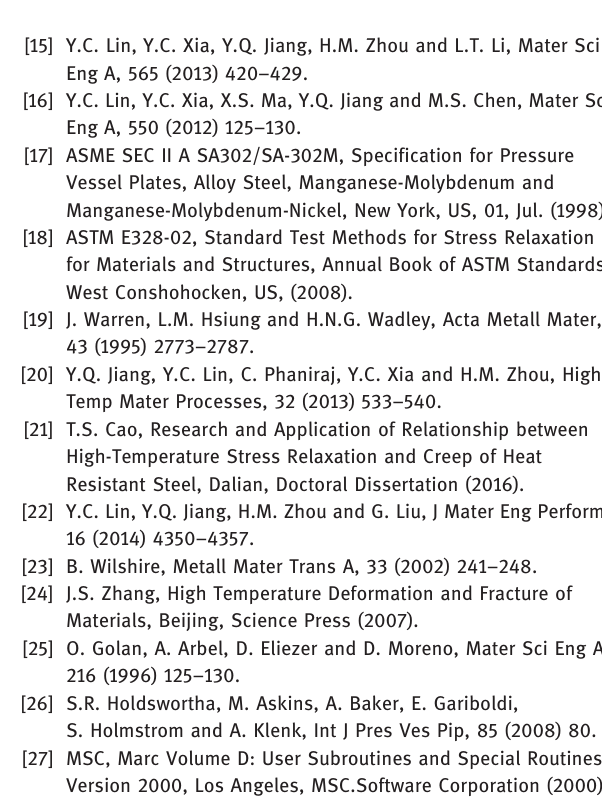
Figure 8: Comparison between the simulated stress relaxation curves and the experimental curves at different temperatures: (a) 620°C; (b) 500°C; (c)